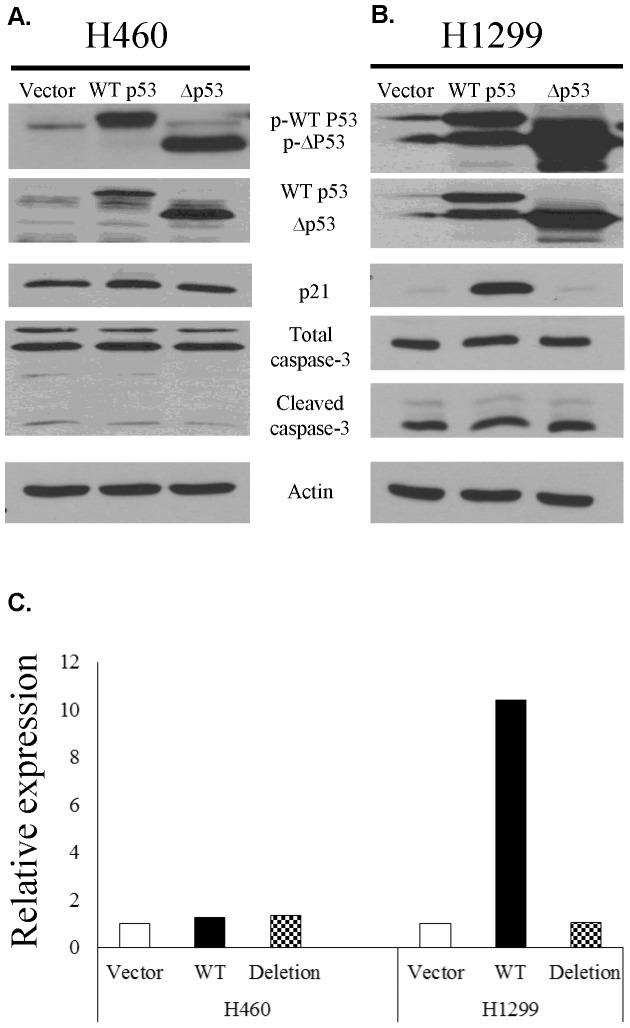
Overexpression of the novel mutant p53 does not induce p21 expression in p53-deficient H1299 cells.A. Overexpression of WT p53 or the deletion mutant in H460 cells resulted in higher expression of the truncated protein than the full length transcript; comparable levels of phosphorylated p53, p21, total caspase 3 and cleaved caspase 3 were observed. B. Overexpression of the same in H1299 cells resulted in similar protein expression patterns with the exception of p21, which was expressed as a result of transfection with WT p53 but not the deletion mutant. C. RT-PCR analysis confirms that similar levels of p21 are present in H460 cells transfected with the WT or mutated p53 and that H1299 cells transfected with WT p53 express much higher levels of p21 than those transfected with the mutant.